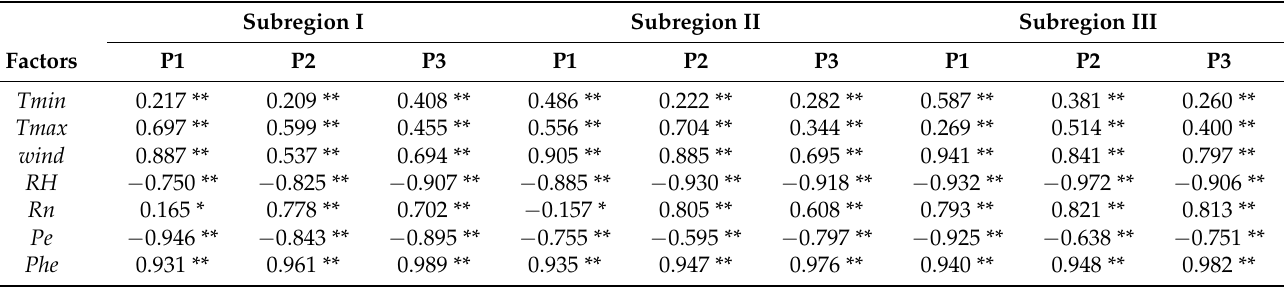
Table 1. Partial correlation coefficient and significance between IR and various factors in spatial distribution in P1, P2 and P3 stages of winter wheat.